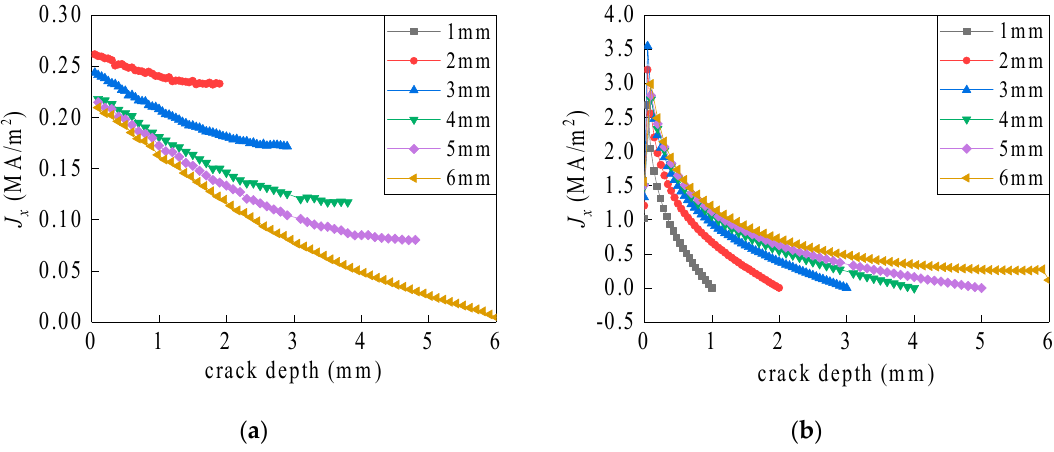
Figure 9. Current density distribution along a vertical axis of symmetry associated with the inner sides of the crack. ( a ) Line a and ( b ) line b.